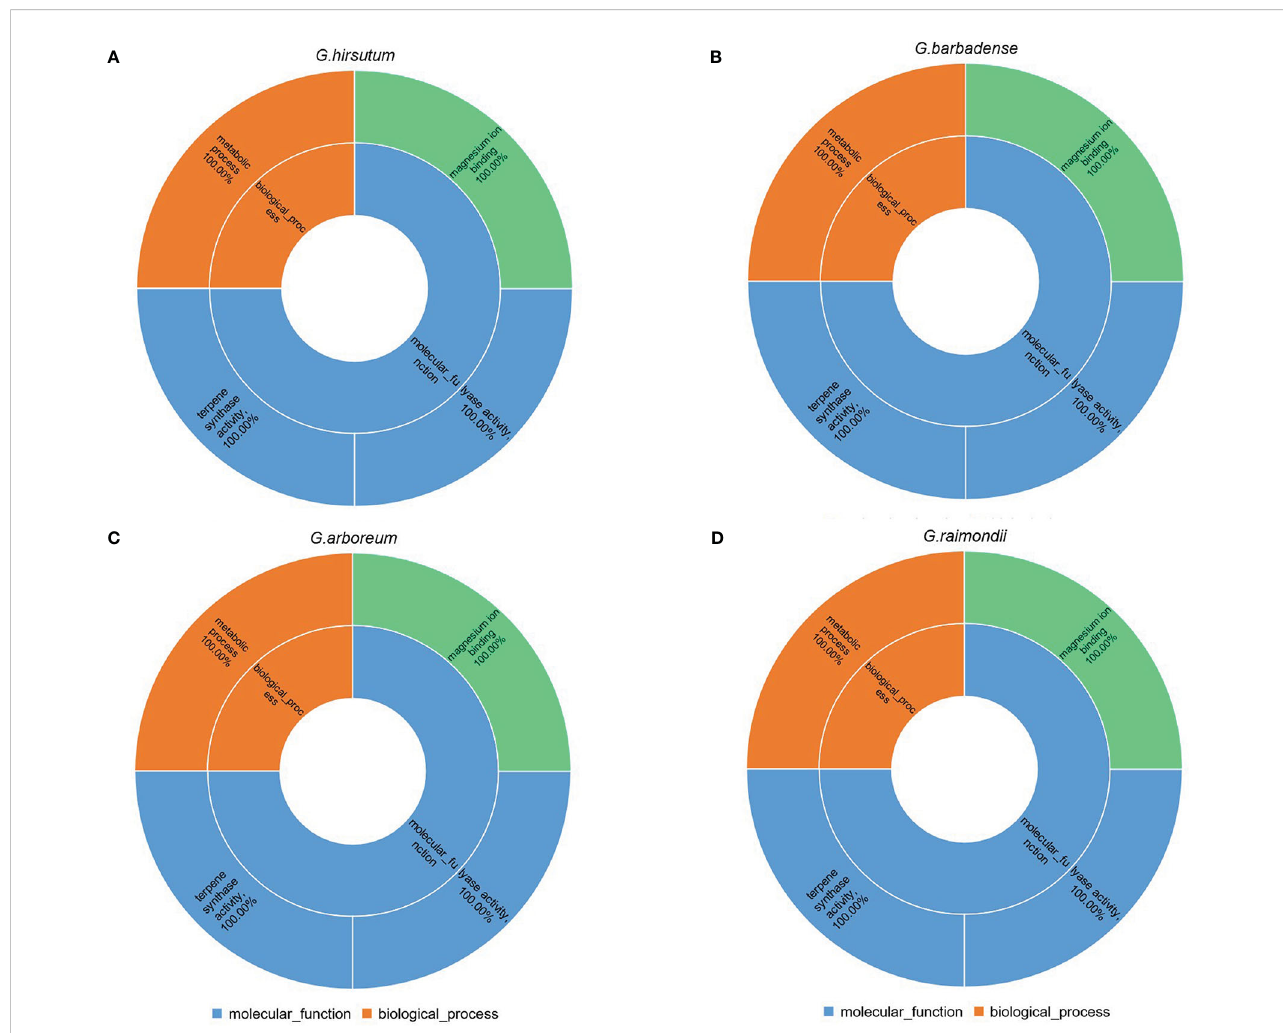
FIGURE 7 GO analysis of 260 TPSs. (A – D) represents GO enrichment of G. hirsutum , G. barbadense , G.arboreum , G. raimondii ,